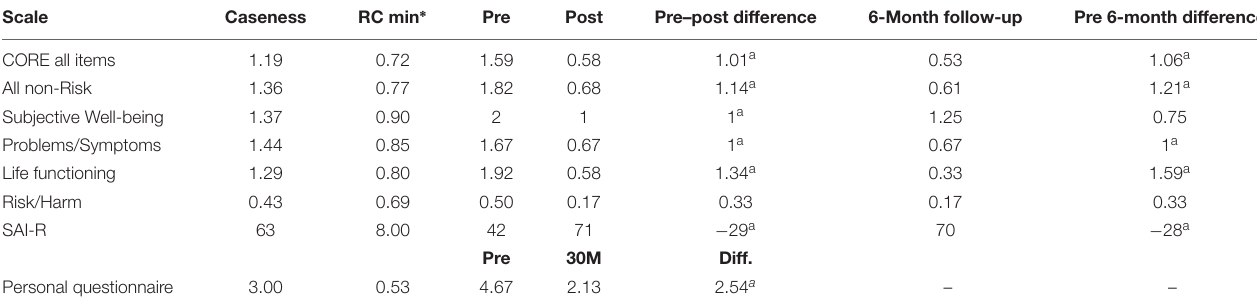
TABLE 1 | John’s outcome